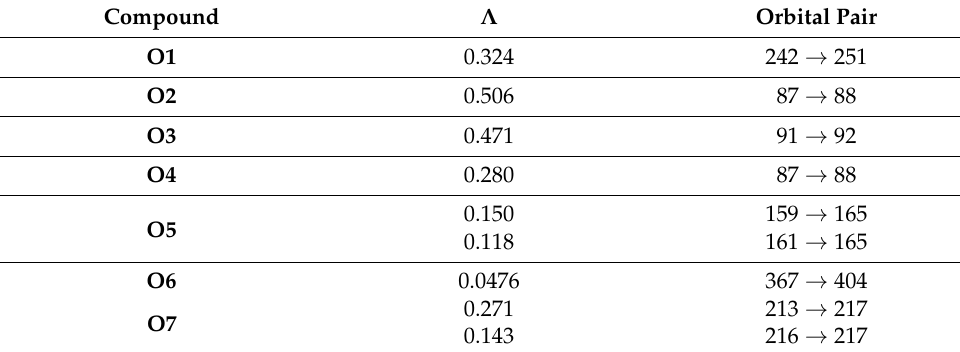
Table 12. Degree of electron–hole overlap ( Λ ) for the first excited state within each